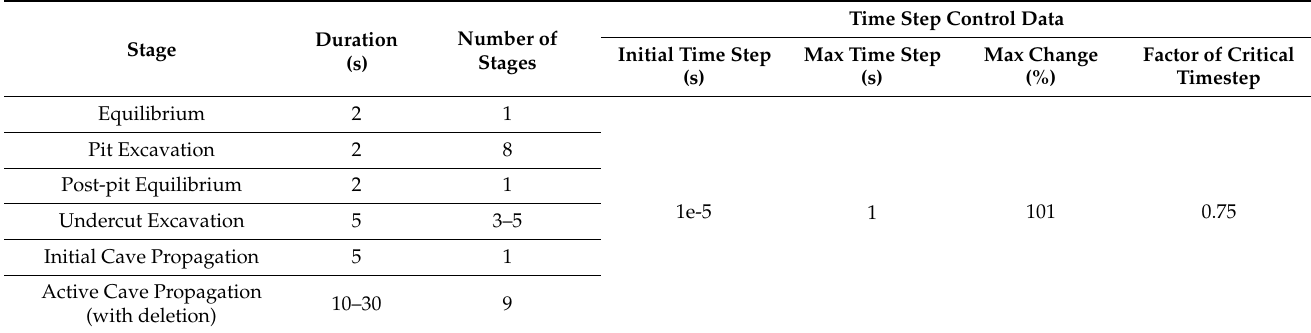
Table 4. ELFEN model stages and time step controls.